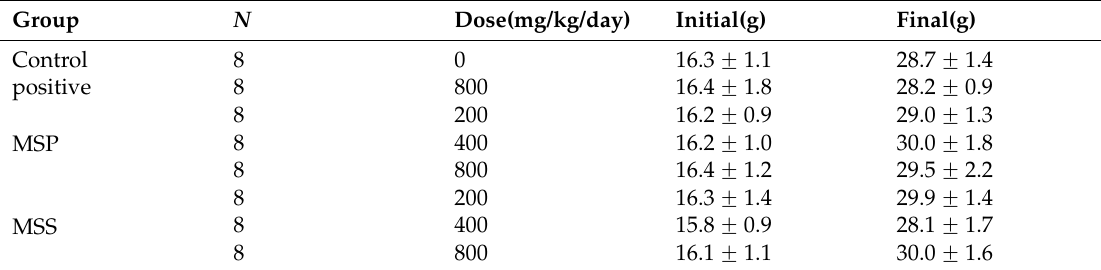
Table 1. The body weights of mice in all treatment groups ( ¯ x ± SD).